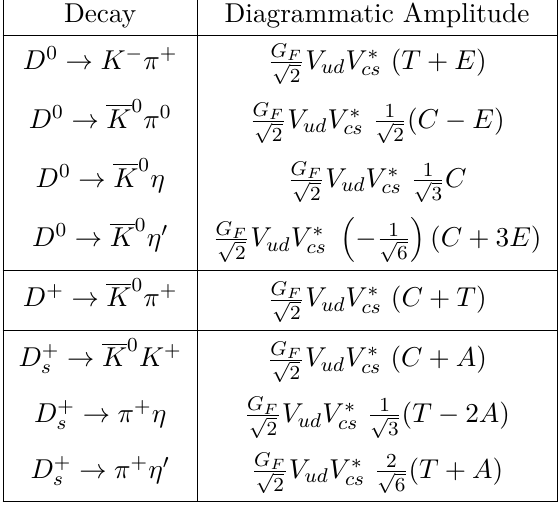
Table 5. Amplitudes for CF D decays expressed in terms of SU(3) F flavor-topological